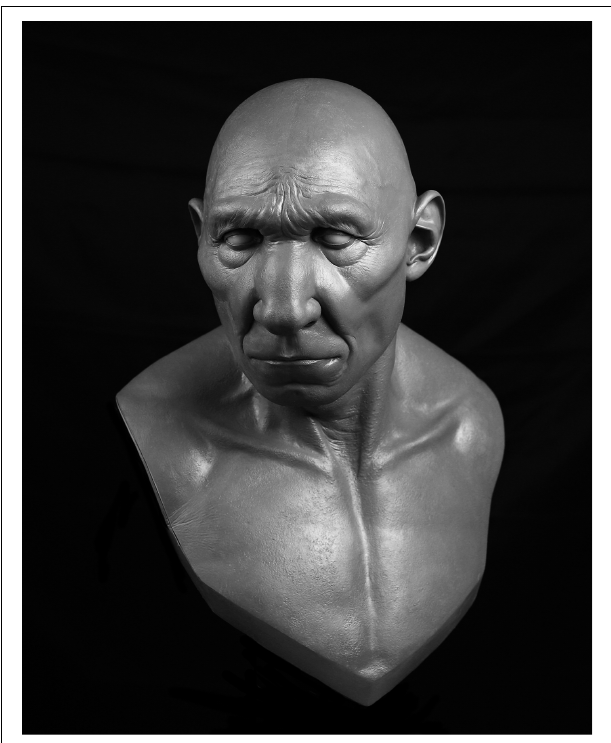
FIGURE 6 | Facial reconstruction of Amud 1 (without hair and pigment) produced in 2019 that employed facial soft tissue regression models developed in Simpson and Henneberg (2002) from modern human